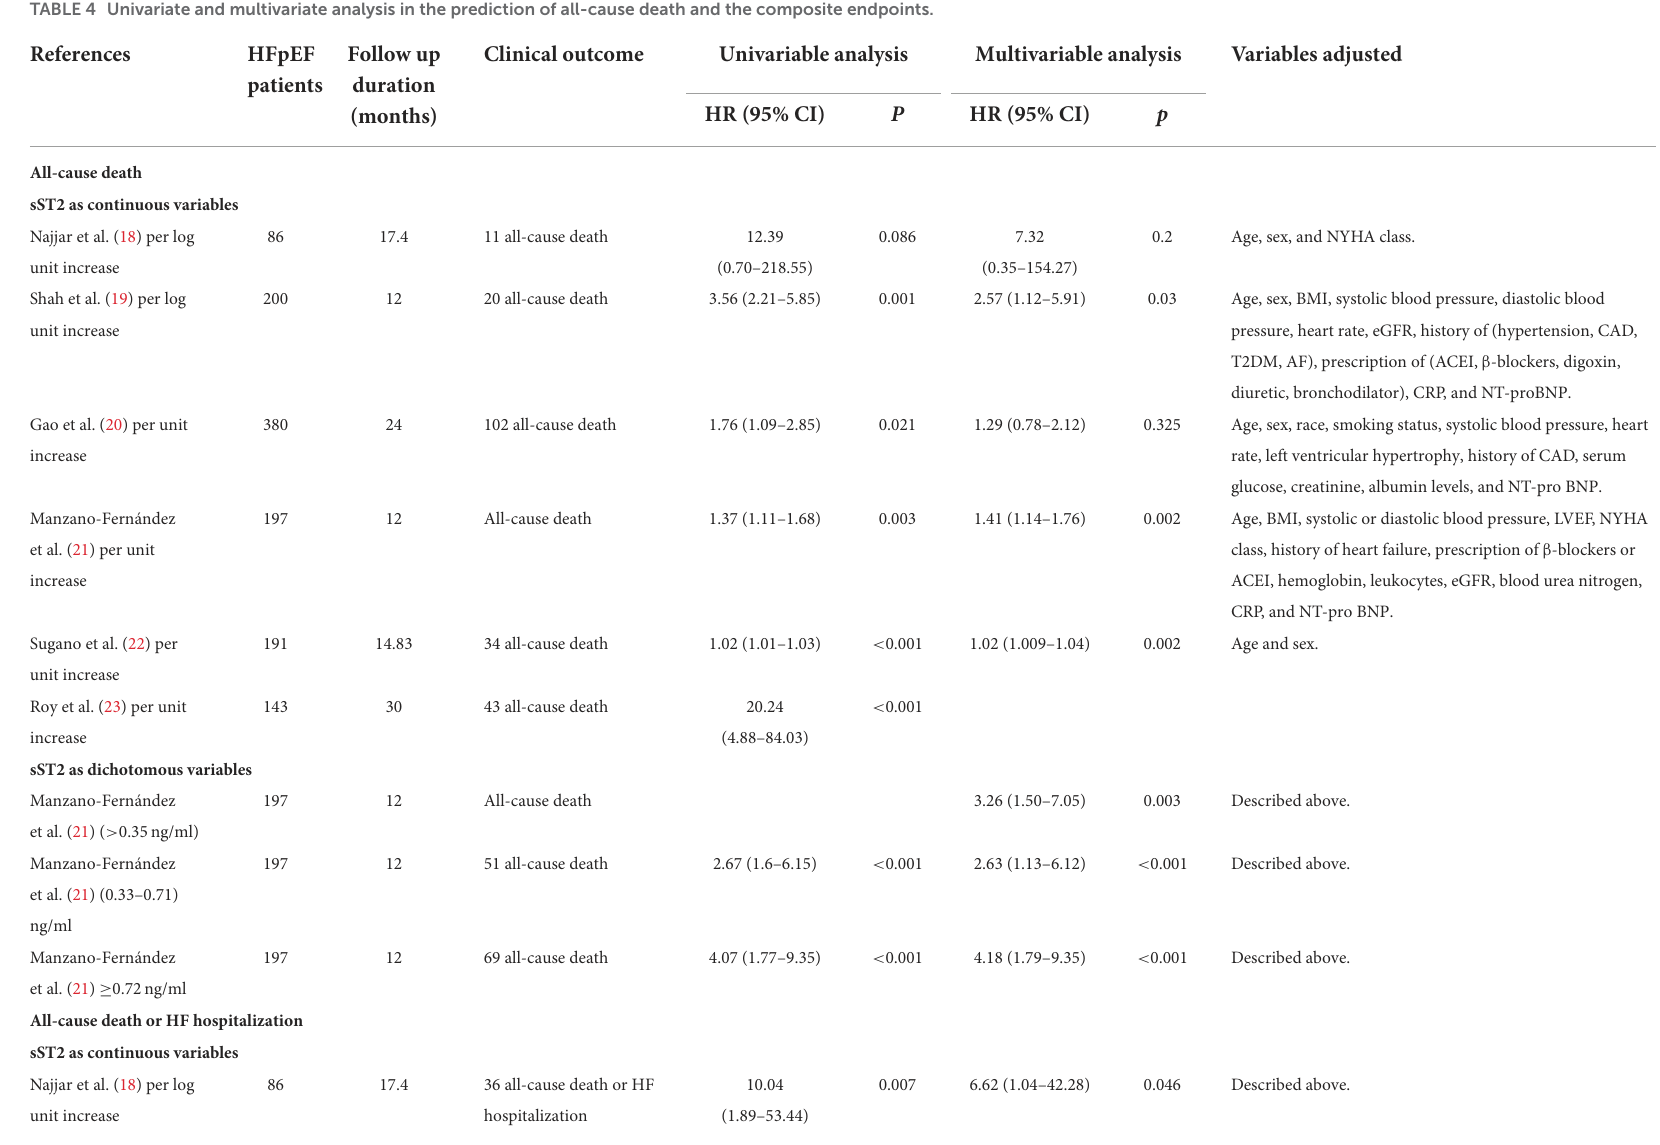
TABLE 4 Univariate and multivariate analysis in the prediction of all-cause death and the composite